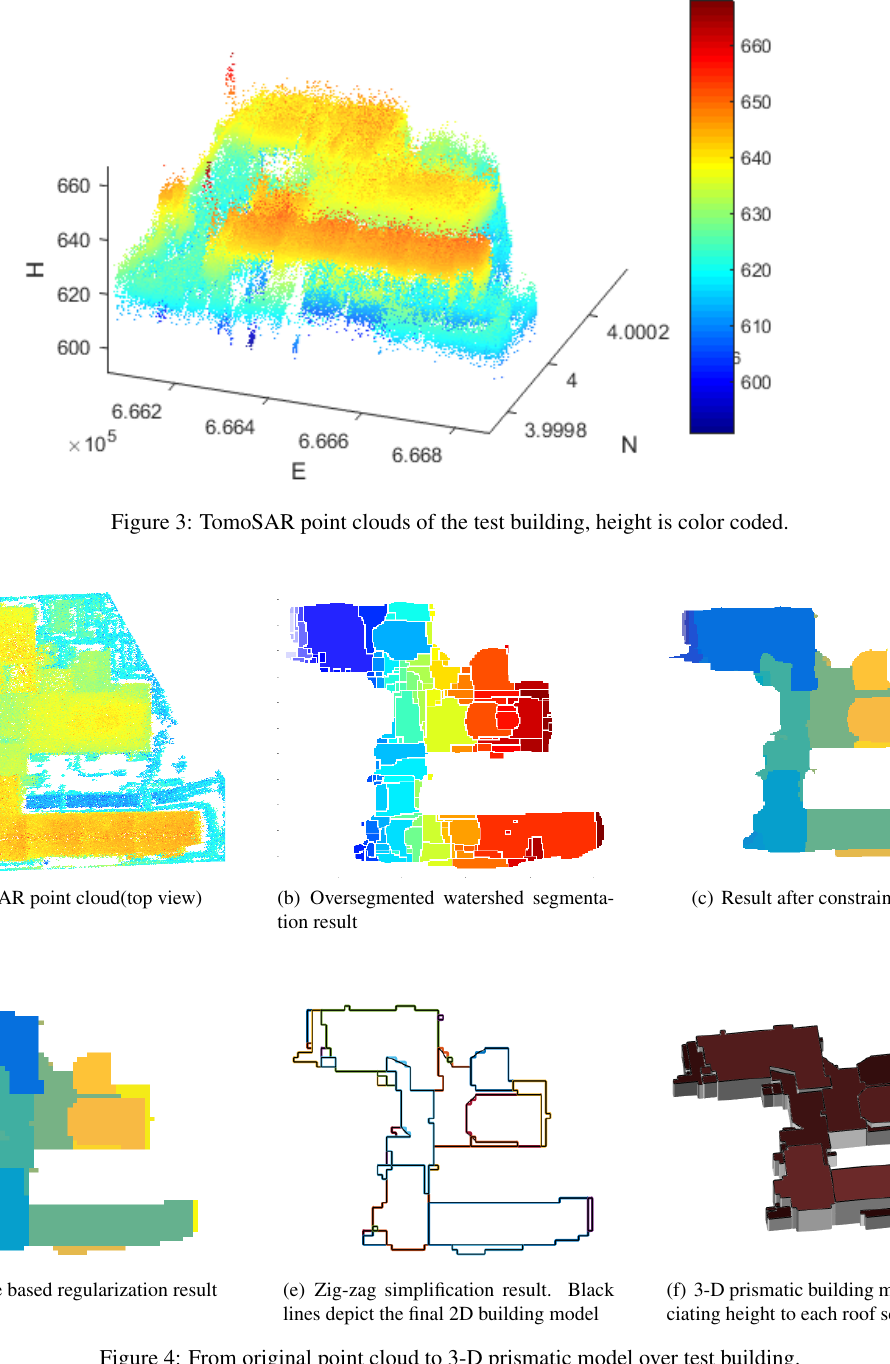
Figure 4: From original point cloud to 3-D prismatic model over test